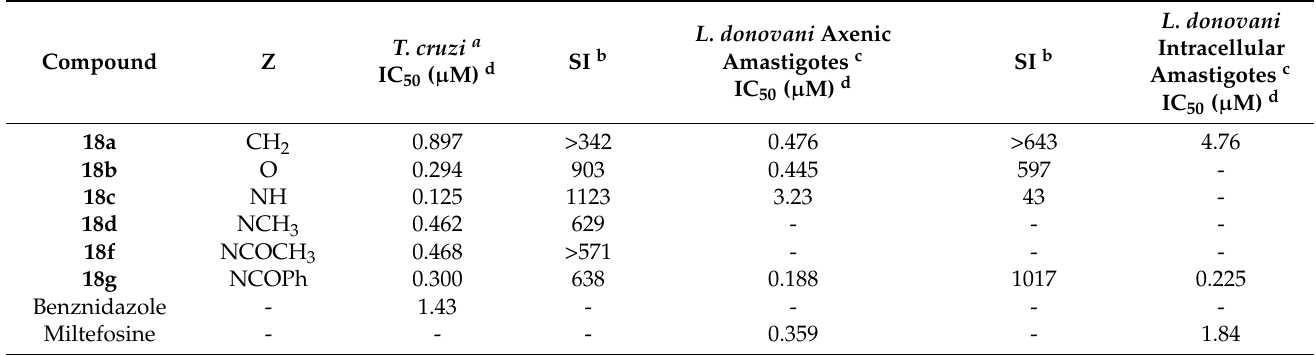
Table 2. In vitro activity of selected compounds against T. cruzi and L. donovani